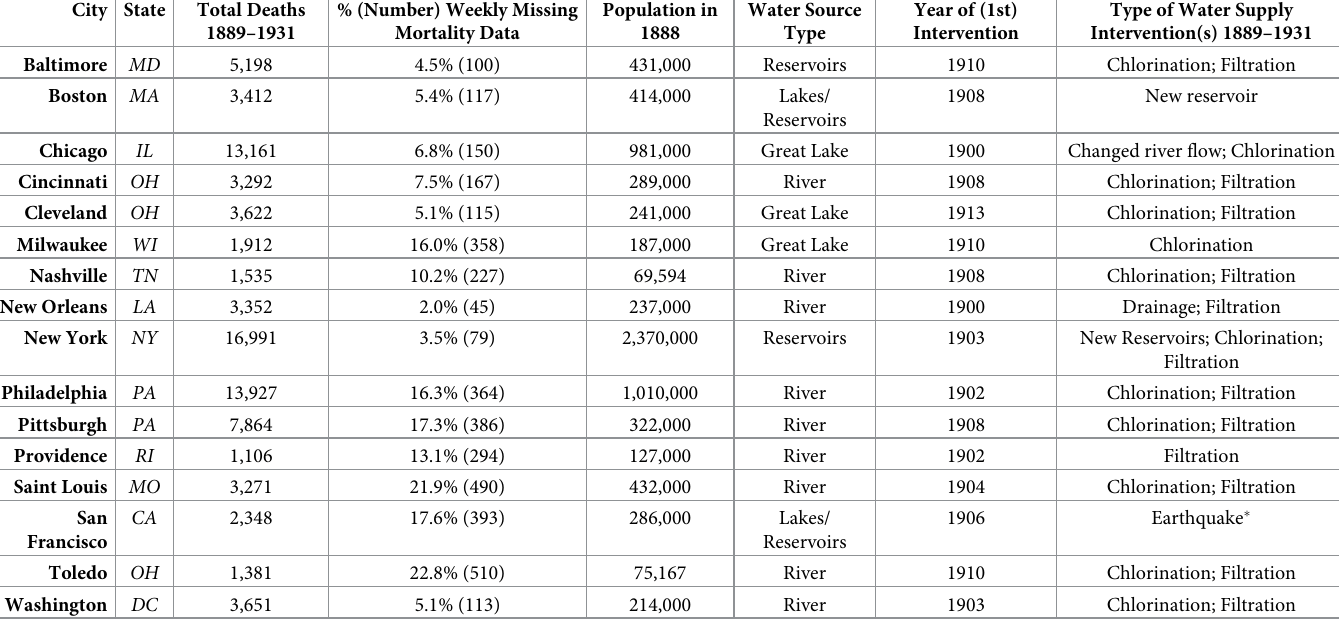
Table 2. Descriptive statistics of cities and their water supplies. "Total Deaths" are the number reported after imputation for missing data. Missing data numbers repre- sent estimates after correcting for “true zeros” in the datasets, and before